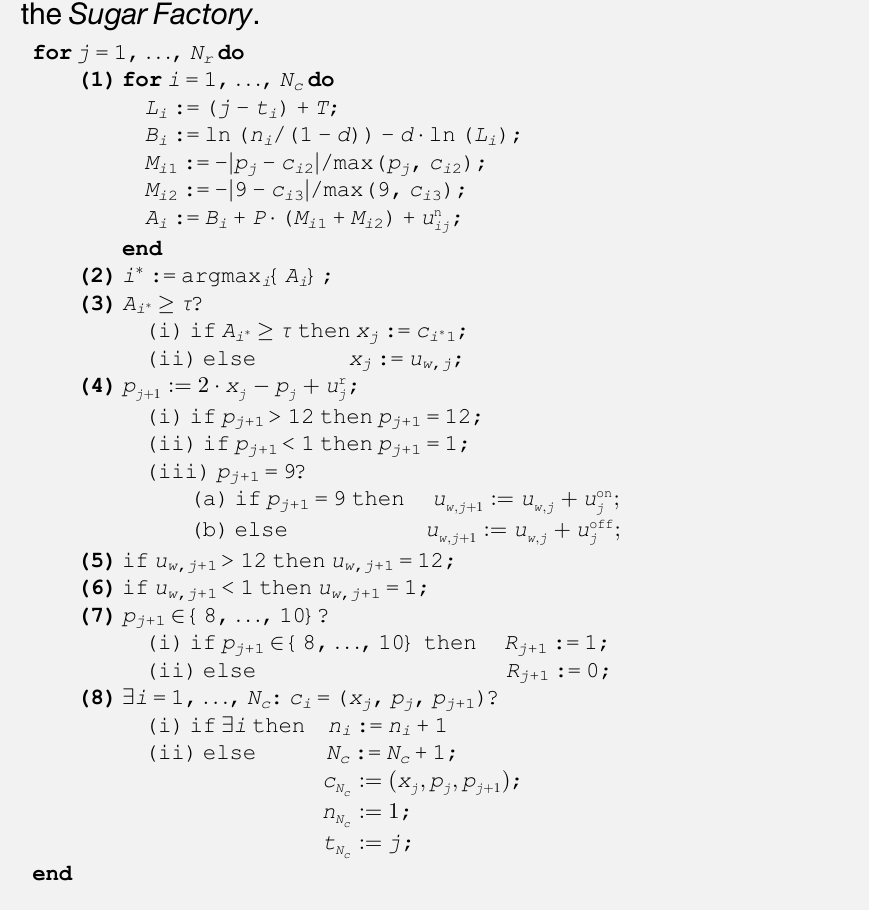
Box 1. Algorithm 1: Mathematical formulation of the ACT-R model of the Sugar Factory